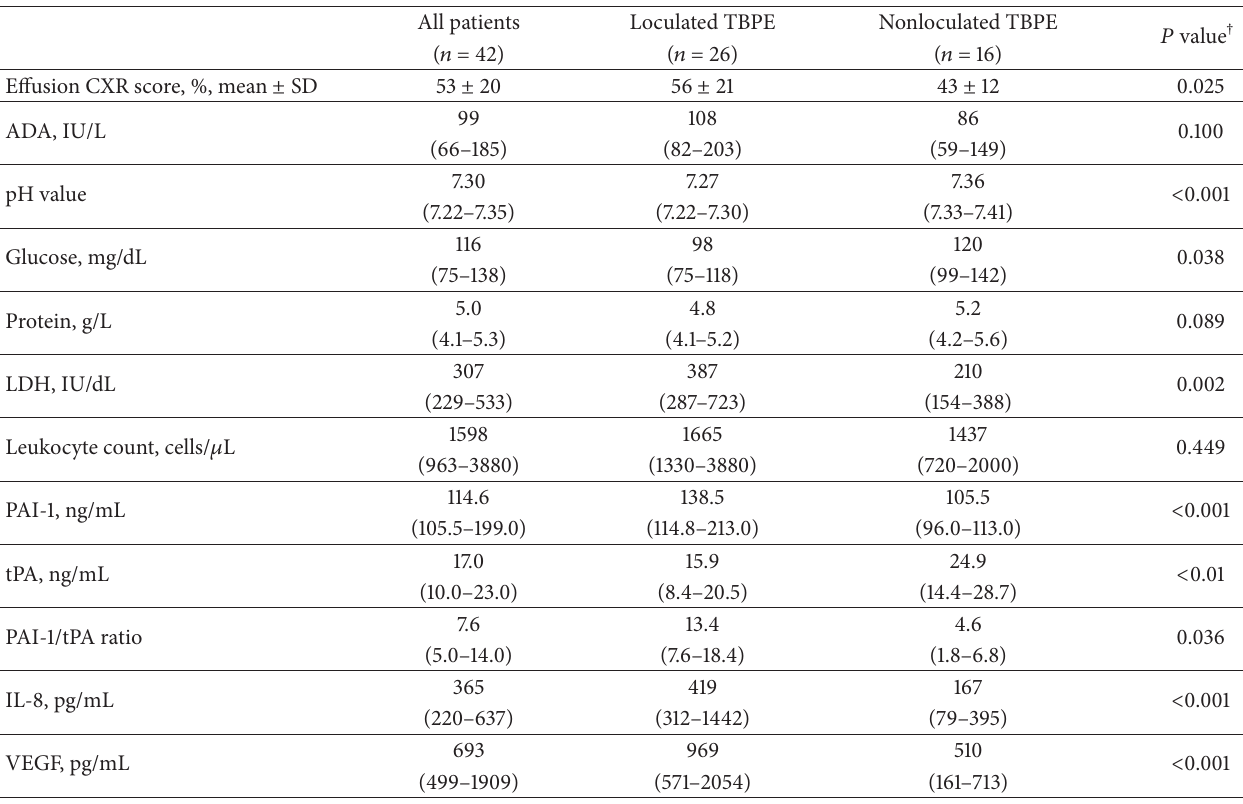
Table 2: Pleural effusion variables between loculated and nonloculated tuberculous pleural